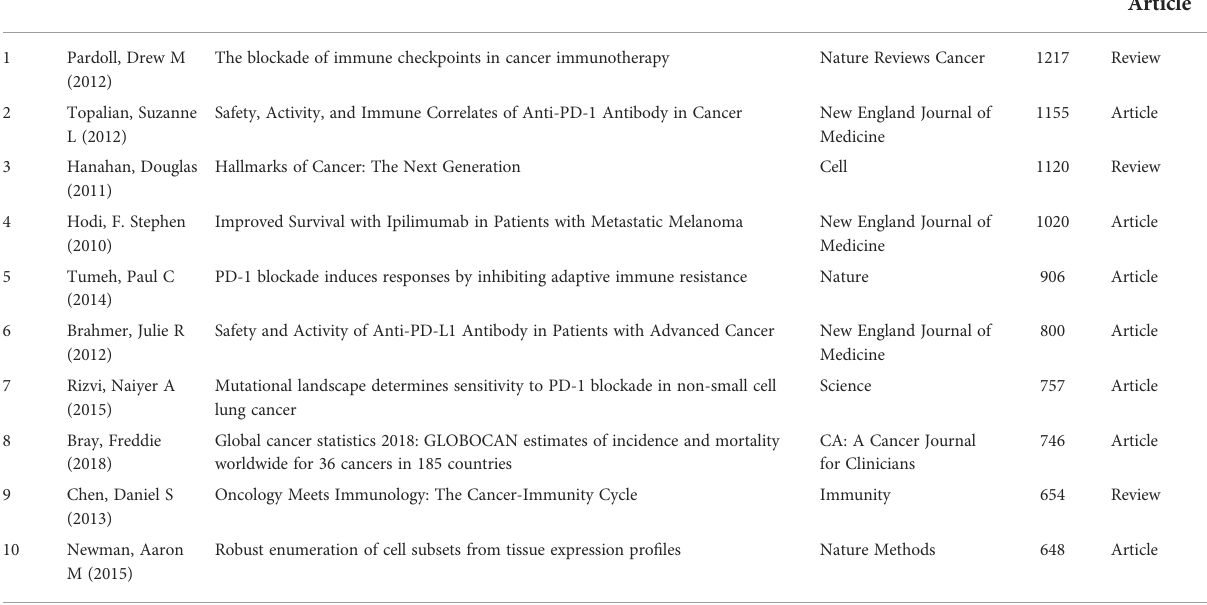
TABLE 6 Top 10 co-cited references for immunotherapy-TME-related research.